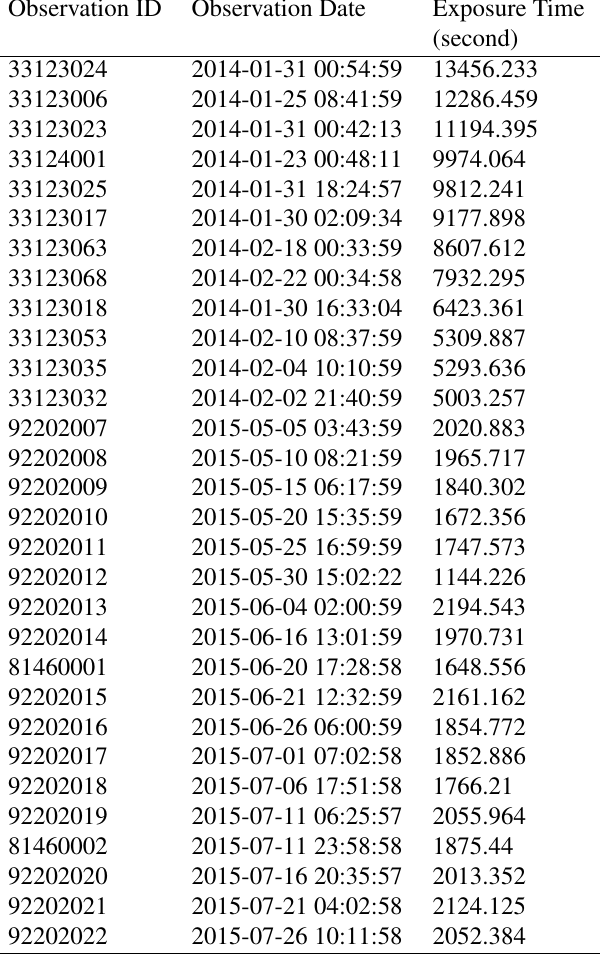
Table 1. Observational data